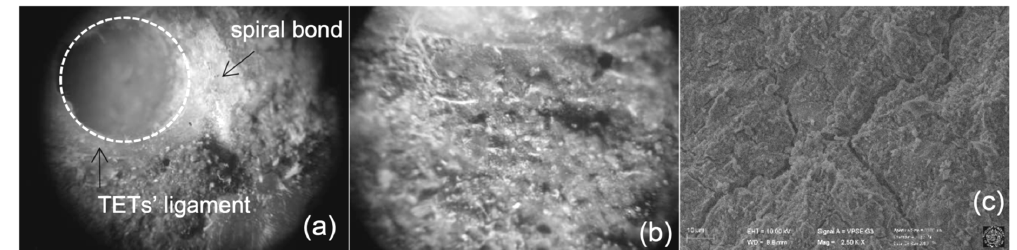
Figure 14. Micrographies of the crack surface; ( a ) TETs’ ligament detail observed with light microscopy; ( b ) presence of white spread crystal close to TETs’ ligaments observed again with light microscopy; ( c ) SEM image of fragments collected from crack surface.